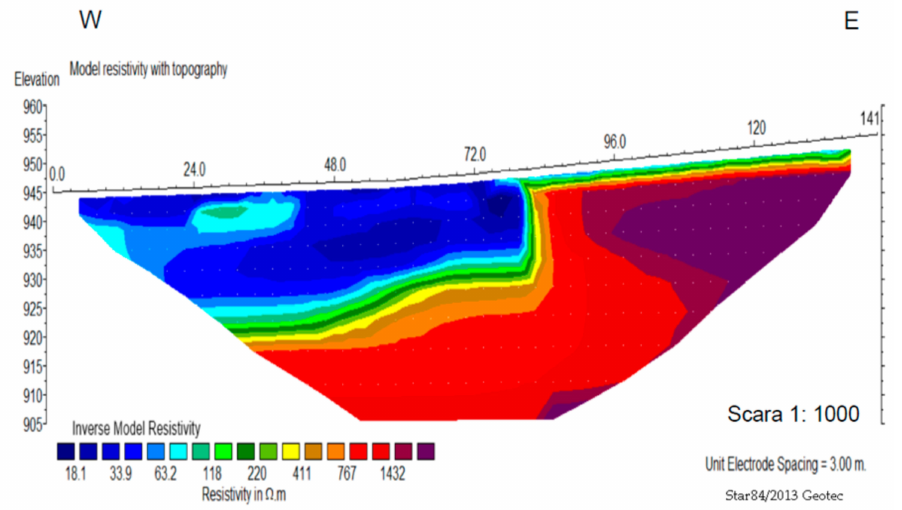
Figure 19. Model resistivity with topography in Bisoca station.